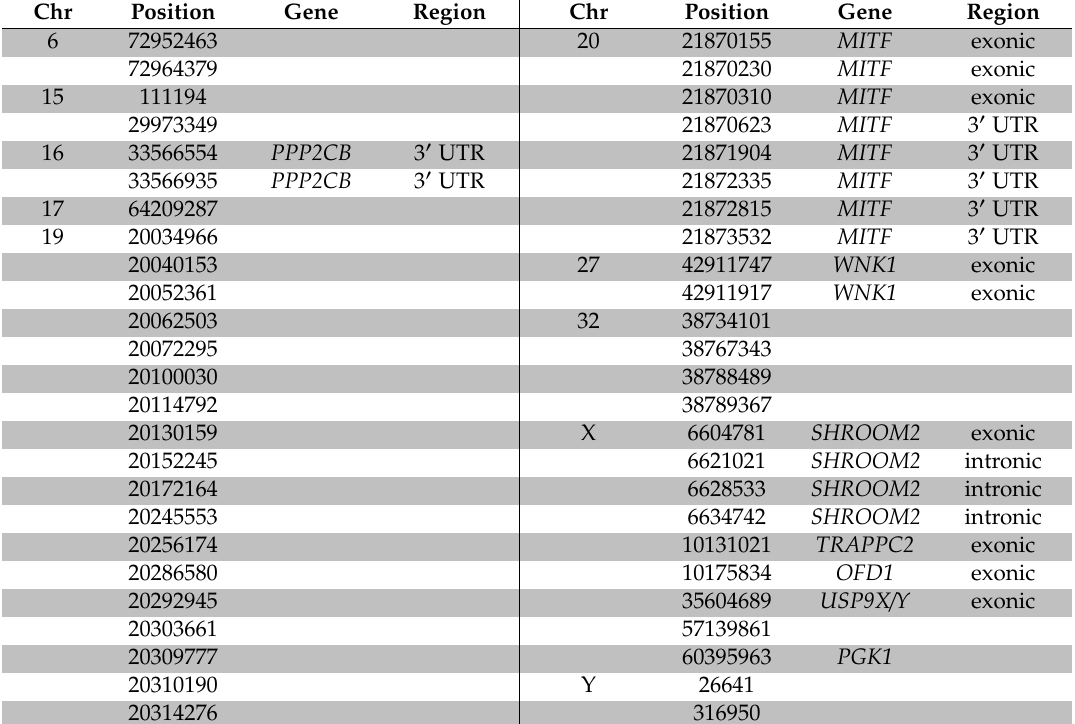
Table 1. Genome-wide significant markers identified in a GWAS for sex ( P -value = 1.58 × 10 − 14